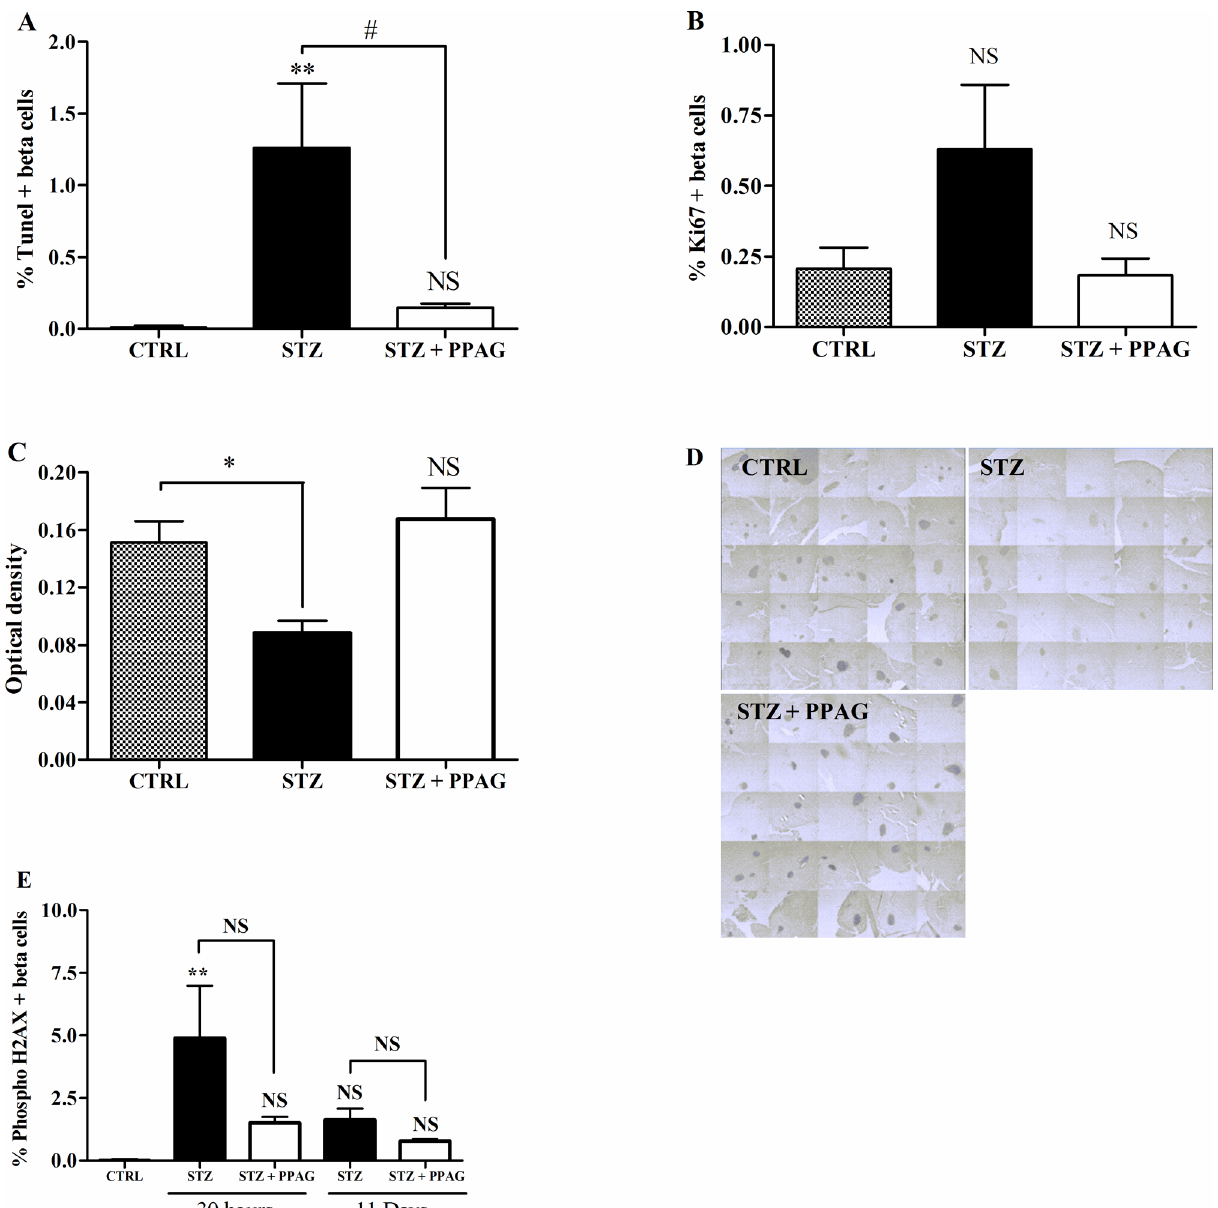
Fig 2. Effect of STZ and PPAG on beta cell apoptosis/proliferation and the expression of BCL2 and phospho H2AX. Shaded bars: untreated controls, CTRL (n = 5); filled bars: STZ-treated animals, STZ (n = 4); open bars: STZ-treated animals that were treated with PPAG, STZ+PPAG (n = 4). (A) Percentage of TUNEL stained cells in the insulin-positive cell population in pancreatic tissue sections. (B) Percentage of Ki67 stained cells in the insulin-positive cell population in pancreatic tissue sections. Values are mean ± SEM. Significance compared to the control was determined by one-way ANOVA with Dunnett post-test. ** P < 0.01; NS (not significant). For the effect of PPAG on STZ induced apoptosis a one-sample t-test was used. #P < 0.05. (C) Densitometric quantification of BCL2 expression in the islets. Values are mean ± SEM. Significance compared with the control was determined using an one-way ANOVA with a Dunnett post-test. ** P < 0.01; NS (not significant). (D) Representative images of the BCL2 staining in pancreatic islets, 30 hours post-STZ. (E) Beta cell DNA damage/repair. Shaded bars: untreated controls, CTRL (n = 5); filled bars: STZ-treated animals, STZ (n = 4 for 30 hours and n = 3 for 11 days); open bars: STZ-treated animals that were treated with PPAG, STZ+PPAG (n = 4 for 30 hours and n = 4 for 11 days). No positive cells were detected in control animals. Results from STZ and STZ+PPAG were not statistically different (p (cid:1) 0.05). ** p < 0.01 between control group and STZ.